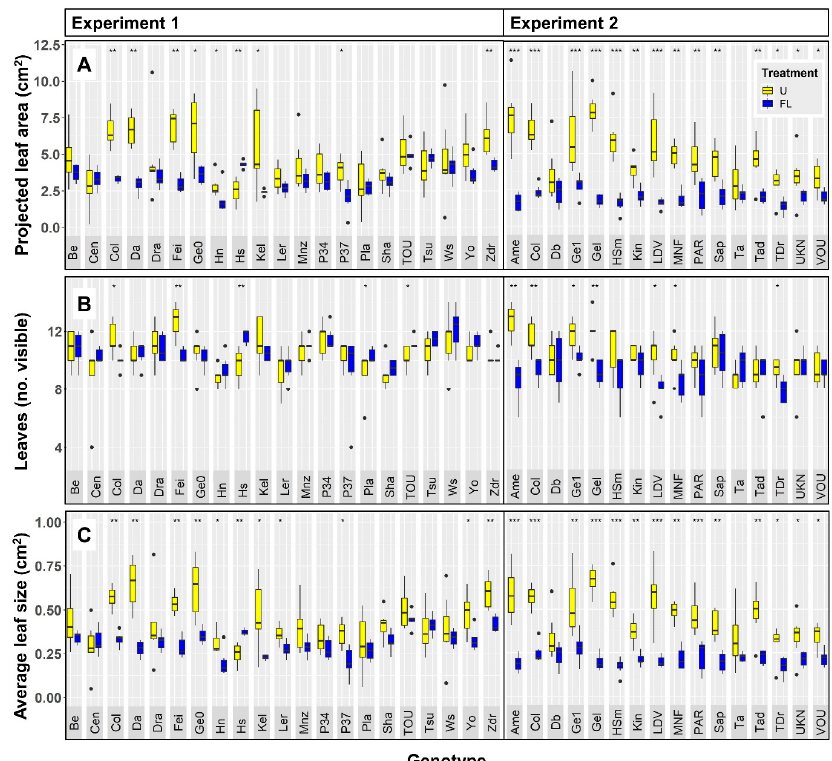
Figure 2. Growth and development of 36 Arabidopsis accessions acclimated to uniform (U; yellow boxes) and fluctuating light intensities (FL; blue boxes), grown in two different experiments. ( A ) Projected leaf area, ( B ) number of visible leaves and ( C ) average leaf size. Values were obtained from chlorophyll a fluorescence pictures. Bars depict interquartile range (IQR; 25th–75th percentile) and median (thick line inside bar), whiskers depict data up to 1.5 × IQR, dots outside whiskers depict outliers ( > 1.5 × IQR). In the case of significant di ff erences between average values under U and FL, these are shown for a given accession as: *** = p < 0.001, ** = p < 0.01 and * = p < 0.05 (n =